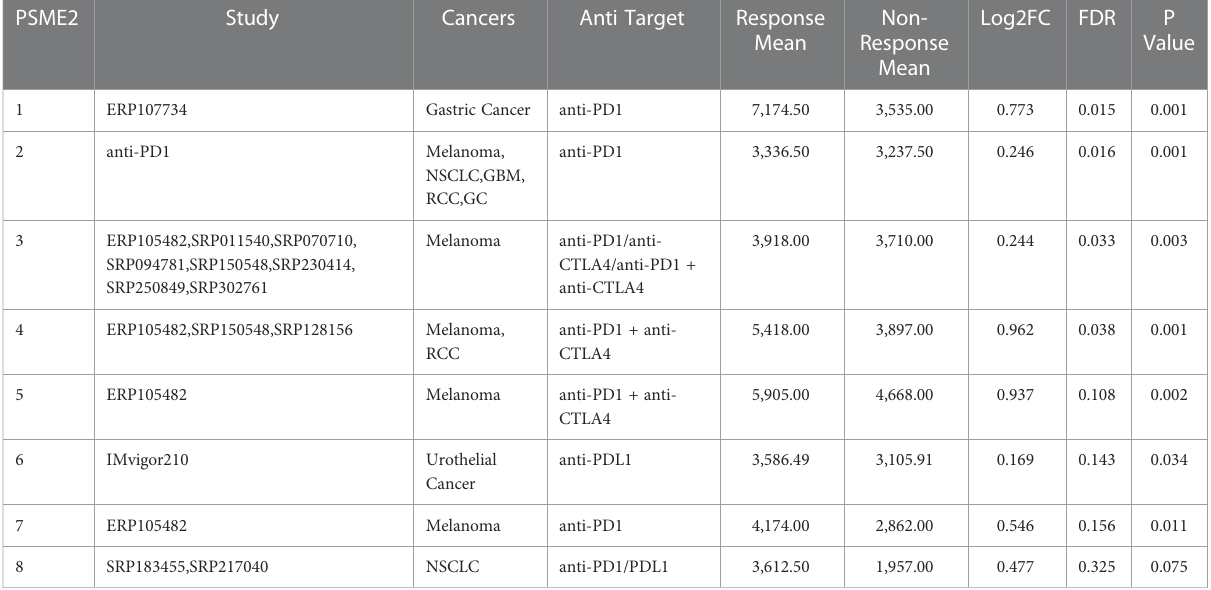
TABLE 5 PSME2 expression distribution for response and non-response based on pre-treatment samples in all datasets.